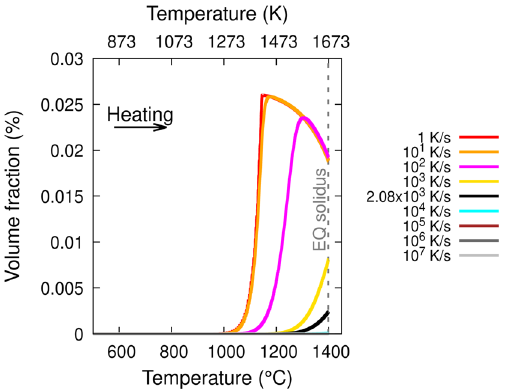
Figure 10. M–S precipitation kinetics simulation predicted volume fraction as a function of temperature during heating at different temperature rates. ‘EQ solidus’ stands for the equilibrium solidus temperature. The black curve corresponds to the minimum heating rate obtained from Fig. 7 between 1273 K and 1673 K. Gnuplot v5.4 (http:// www. gnupl ot. info) was used to prepare this